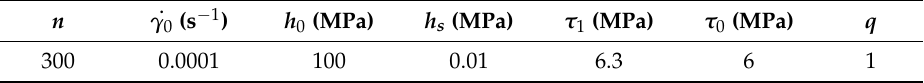
Table A1. Material parameters used in the Bassani–Wu hardening